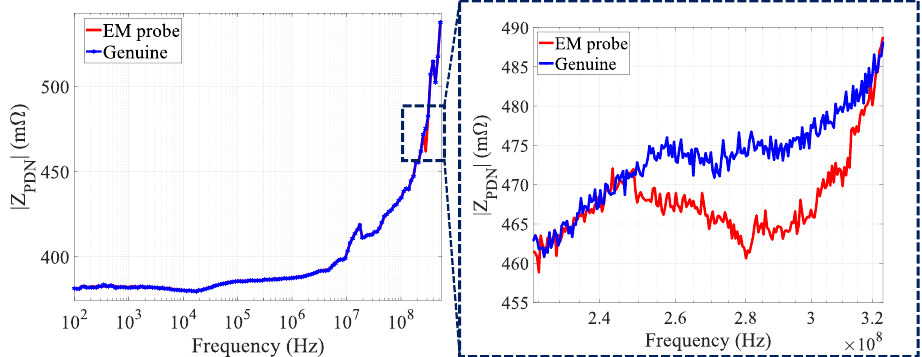
Figure 9: The mean of 105 impedance profile signatures when the EM probe is positioned over the left corner of the